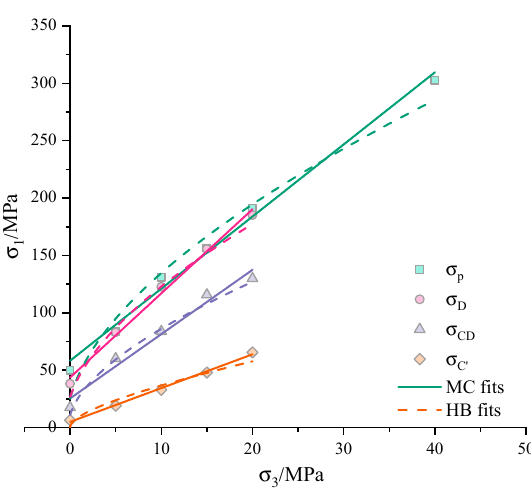
Figure 5. Stresses data and Mohr–Coulomb (MC) and Hoek–Brown (HB) fits for the sandstone.